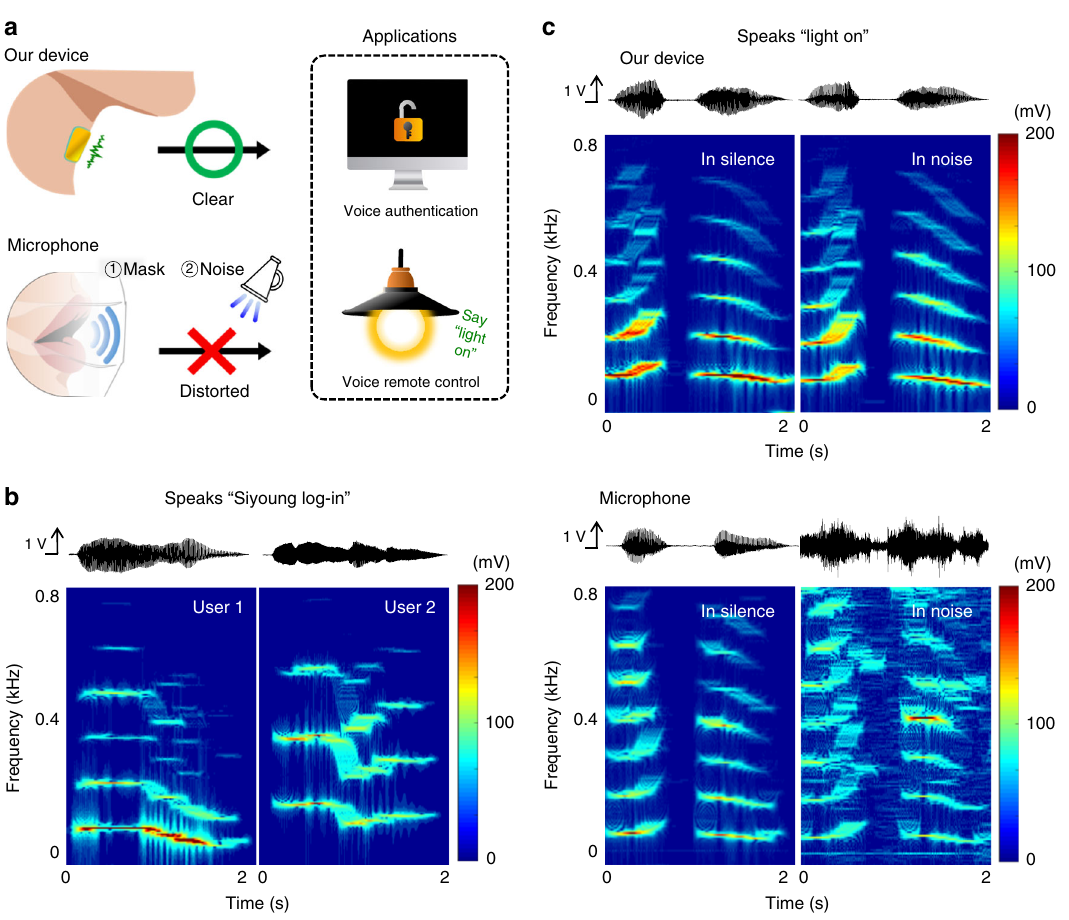
Fig. 5 Voice authentication and speech recognition. a Schematic image of the comparison between our device and a reference microphone (Bruel & Kjaer, microphone type 4192, sensitivity of 1 V Pa − 1 ) for voice authentication and voice-controlled applications. b Output waveform and frequency spectrum measured by our device attached on neck when two users phonated “ Siyoung log-in ” , respectively. Unique voice sound waveform and frequency spectrum of each user ’ s voice are distinguishable. c Comparisons of waveform and frequency spectrum measured by our device and the reference microphone in silent and in noisy (62 dB SPL ) environments, when a person phonated “ light on